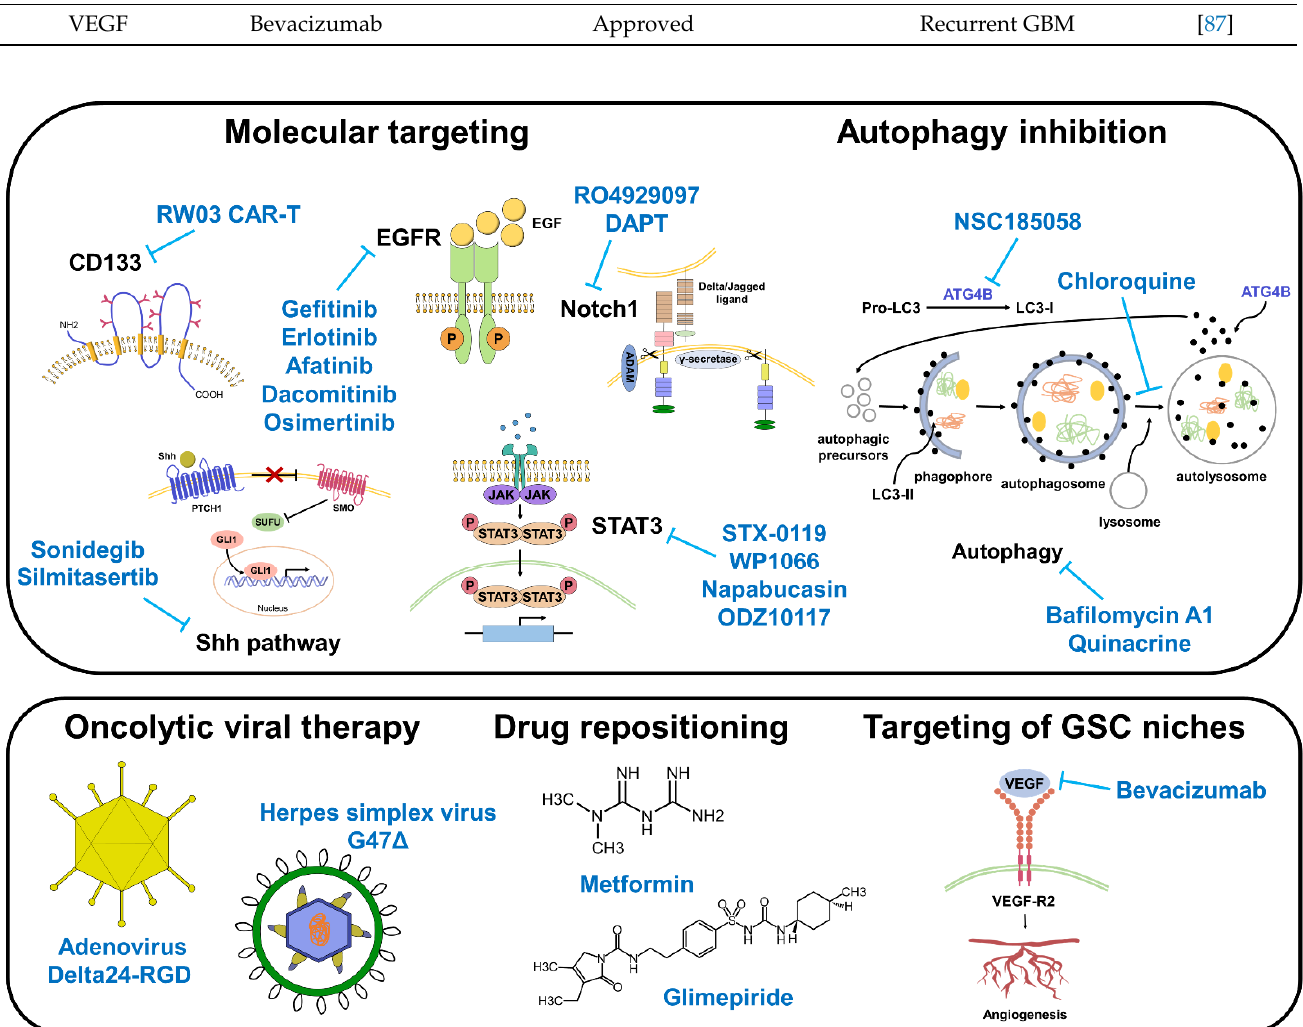
Figure 2. Therapeutic strategies targeting GSCs. Various approaches exist for targeting GSCs, including molecular targeting, autophagy inhibition, oncolytic viral therapy, drug repositioning, and targeting of GSC niches.